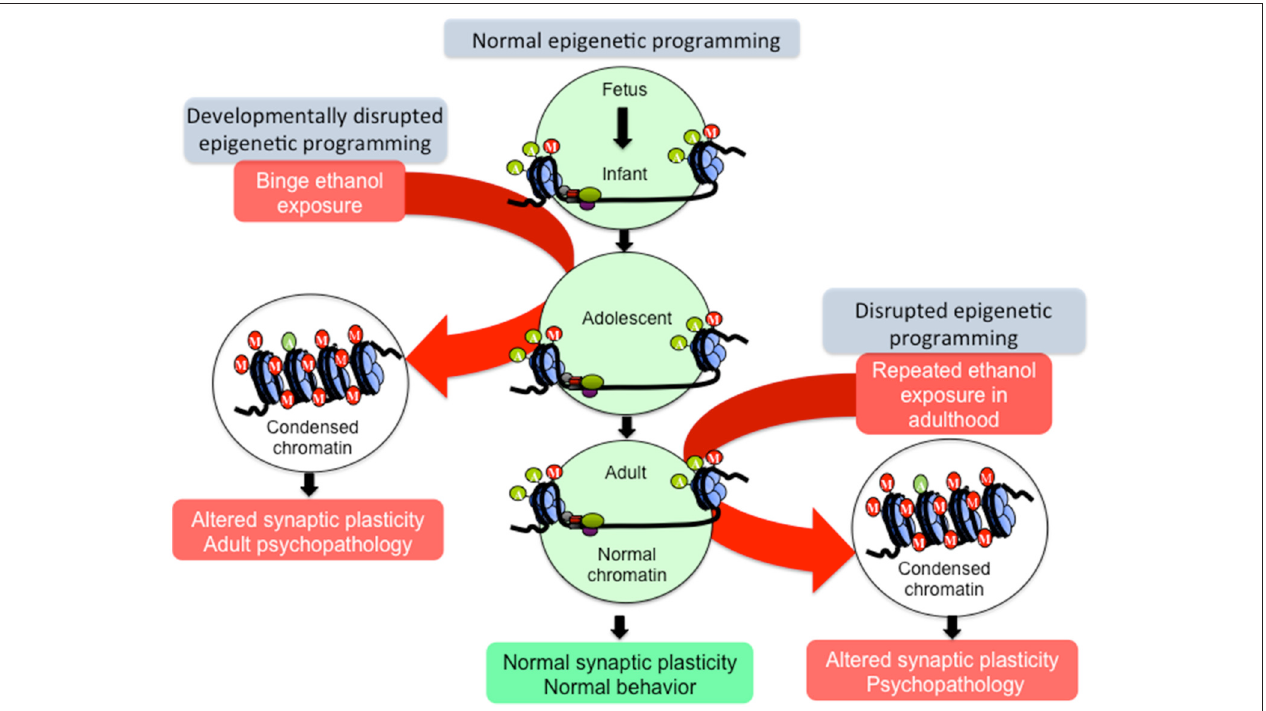
FIGURE 2 | Hypothetical model of epigenetic reprogramming by alcohol during adolescence. Adolescence is characterized by widespread changes in the developing brain. These changes are underpinned by molecular processes such as epigenetic programming, which turn specific genetic programs on to mediate cell fate determination, axonal outgrowth, dendrite formation and neuronal maturation. These processes, in turn, affect synaptic plasticity and neurocircuit function to shape normal behaviors. However, developmental perturbation by early life and/or binge alcohol exposure during this critical period can produce persistent effects on chromatin remodeling, synaptic plasticity, and brain function in adulthood, leading to alcohol use disorders (AUDs) and comorbid psychopathology including anxiety and depression. Adult exposure of alcohol can also disturb chromatin remodeling and plasticity, but some of these effects may not be